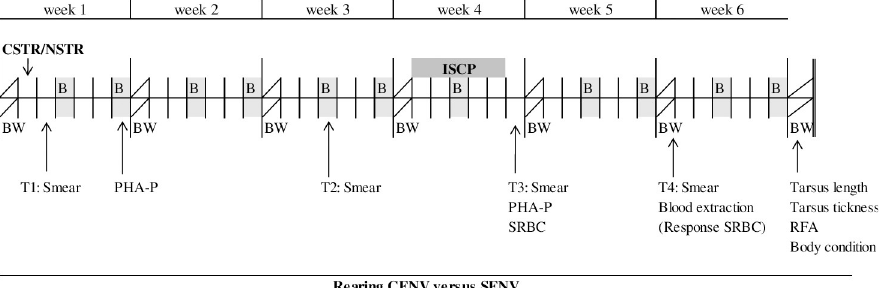
Fig 3. Chronogram of the study. Body weight (BW) was measured the first day of the study in order to balance groups accordingly and every week afterwards; birds were either assigned to a Complex Environment (CENV) or to a Simple Environment (SENV) as their rearing system; on day two of age, half of the birds from each environment were submitted to either a Cold Stress (CSTR) or a No Stress (NSTR) treatment; behavioural observations (B) were performed two times per week except for week four when the Intermittent Stressful Challenges Protocol (ISCP) was applied. The time of the measure of each immunological parameter (smears for accounting the heterophil/lymphocyte ratio (H/L ratio), Phytohemagglutinin-P injection (PHA-P) and Sheep Red Blood Cells injection (SRBC)) are indicated by arrows in the chronogram; at the end of the study we also collected tarsus weight, tarsus thickness and calculated body condition and Relative Fluctuating Asymmetry